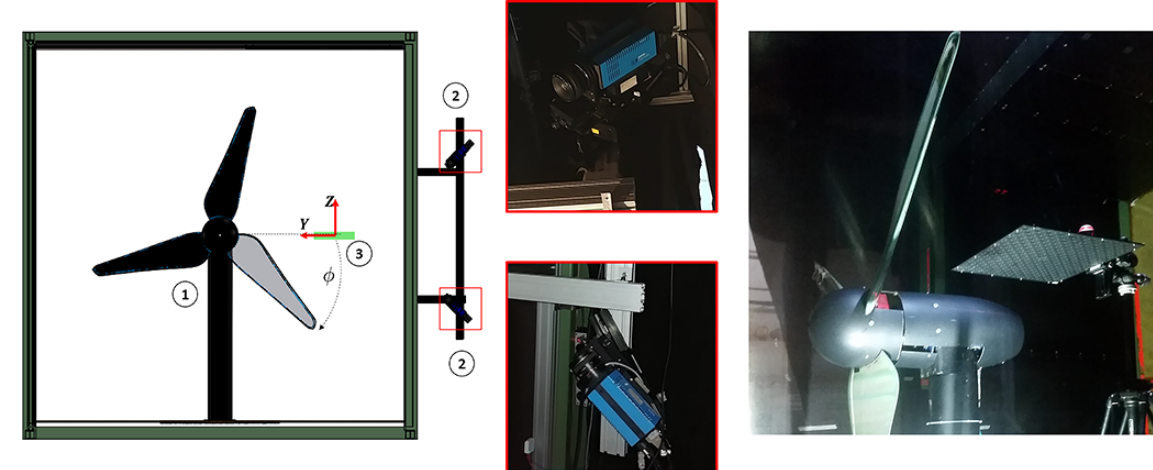
Figure 2. Front view sketch of Berlin Research Turbine (BeRT) (1), cameras (2) and laser sheet (3), left. Camera system, middle. BeRT and calibration target in the test section,